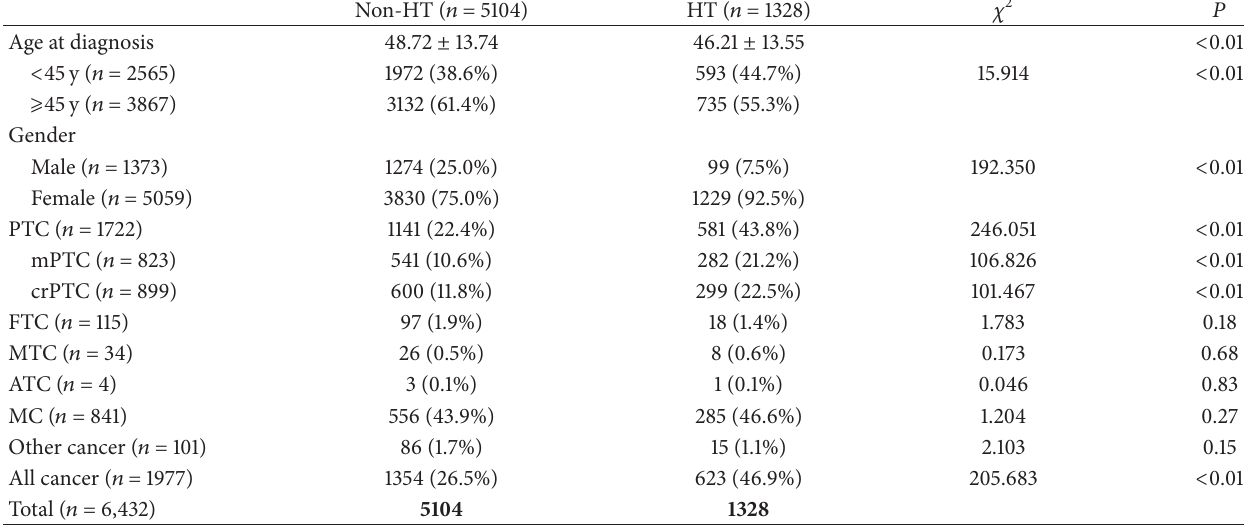
Table 1: Baseline characteristics and thyroid carcinoma distribution between non-HT and HT groups.